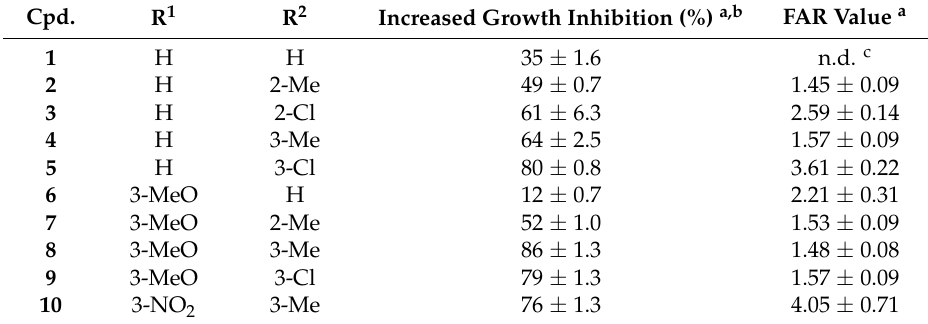
Table 1. Isoniazid (INH) toxicity enhancing activity and P-gp-inhibiting properties of target compounds 1 – 10 . Cpd. R 1 R 2 Increased Growth Inhibition (%) a,b FAR Value a 1 H H 35 ± 1.6 n.d. c 2 H 2-Me 49 ± 0.7 1.45 ± 0.09 3 H 2-Cl 61 ± 6.3 2.59 ± 0.14 H 3-Me 64 ± 2.5 1.57 ± 0.09 3-Cl 80 ± 0.8 3.61 ± 0.22 3-MeO H 12 ± 0.7 2.21 ± 0.31 3-MeO 2-Me 52 ± 1.0 1.53 ± 0.09 3-MeO 3-Me 86 ± 1.3 1.48 ± 0.08 3-MeO 3-Cl 79 ± 1.3 4.05 ±